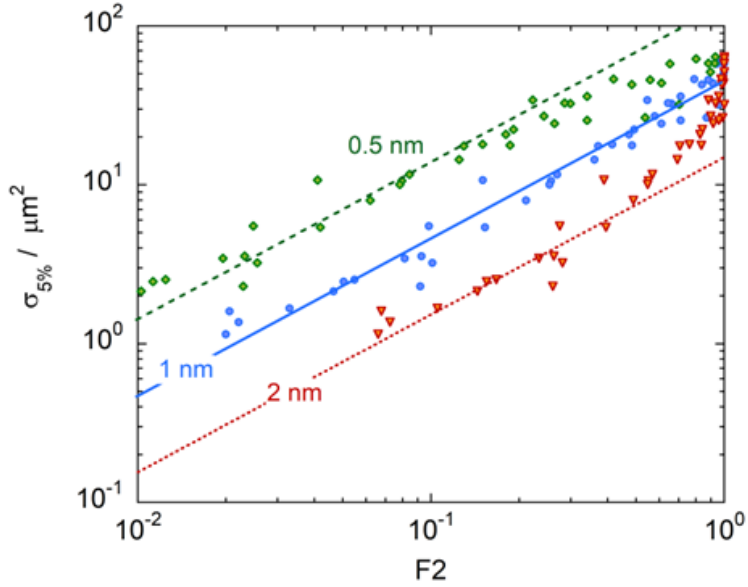
Figure 4. Biological inactivation cross sections at 5% survival, σ 5% , for asynchronous V79 cells irradiated by carbon ions as a function of the cumulative probabilities F 2 ( Q ) calculated in simulated target volumes of diameters 0.5 (green), 1 (blue) or 2 nm (red). Symbols represent biological cross sections derived from data available in literature [24]. Lines are the linear through zero fits of biological data.